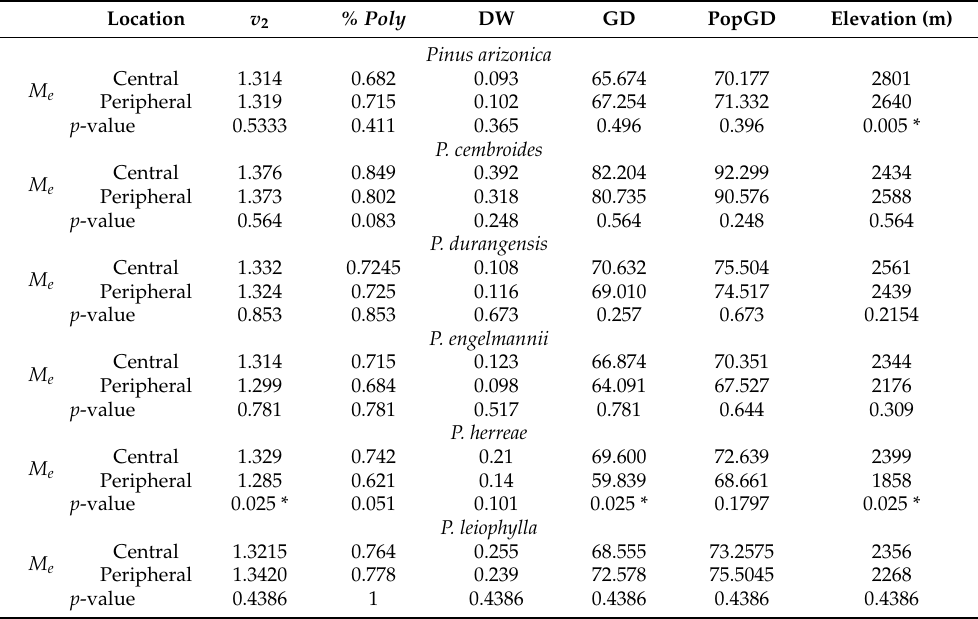
Table 1. Comparison of the differences between central and peripheral populations according to the nonparametric Kruskal–Wallis test using criterion